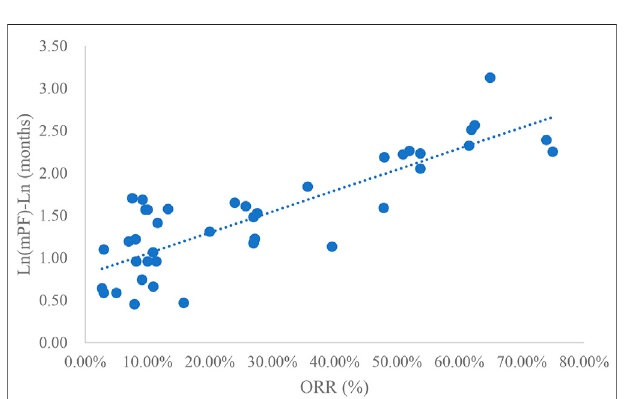
FIGURE 9 | Linear fi tting results for ORR and ln (mPFS).